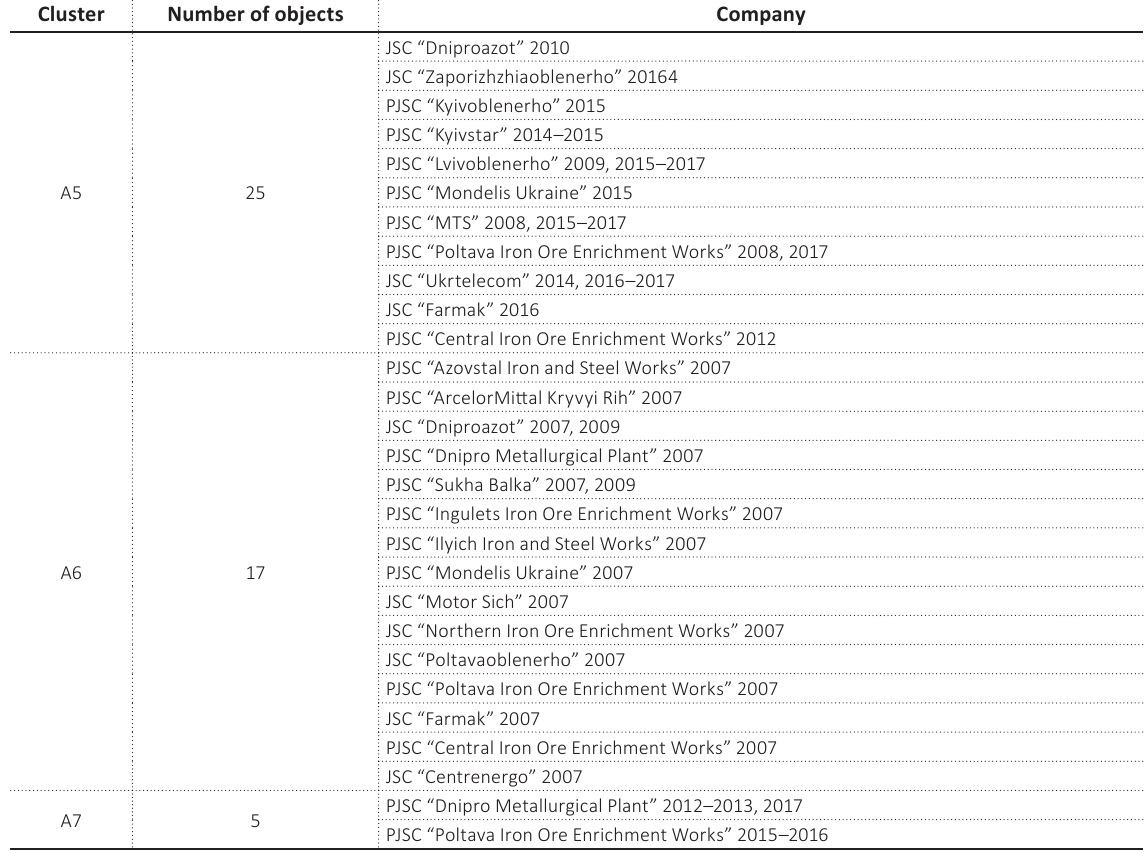
Table 4 (cont.). General characteristics of